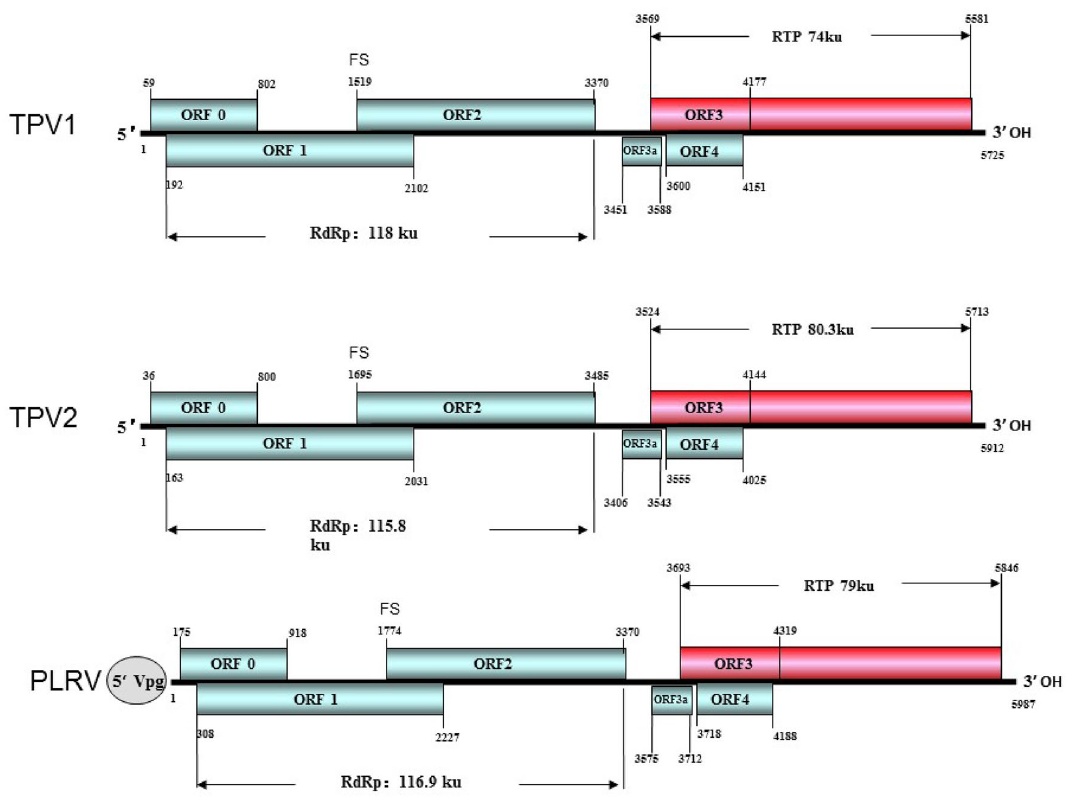
Figure 2. Genome structures of TPV1, TPV2 and PLRV.